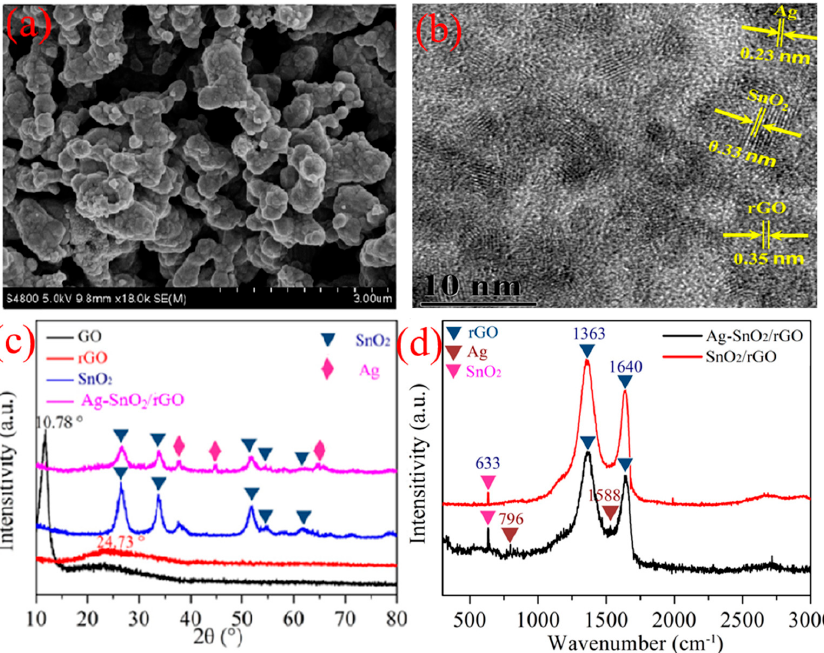
Figure 3. ( a ) SEM characterization of the Ag–SnO 2 /rGO nanocomposite, ( b ) TEM image of the Ag–